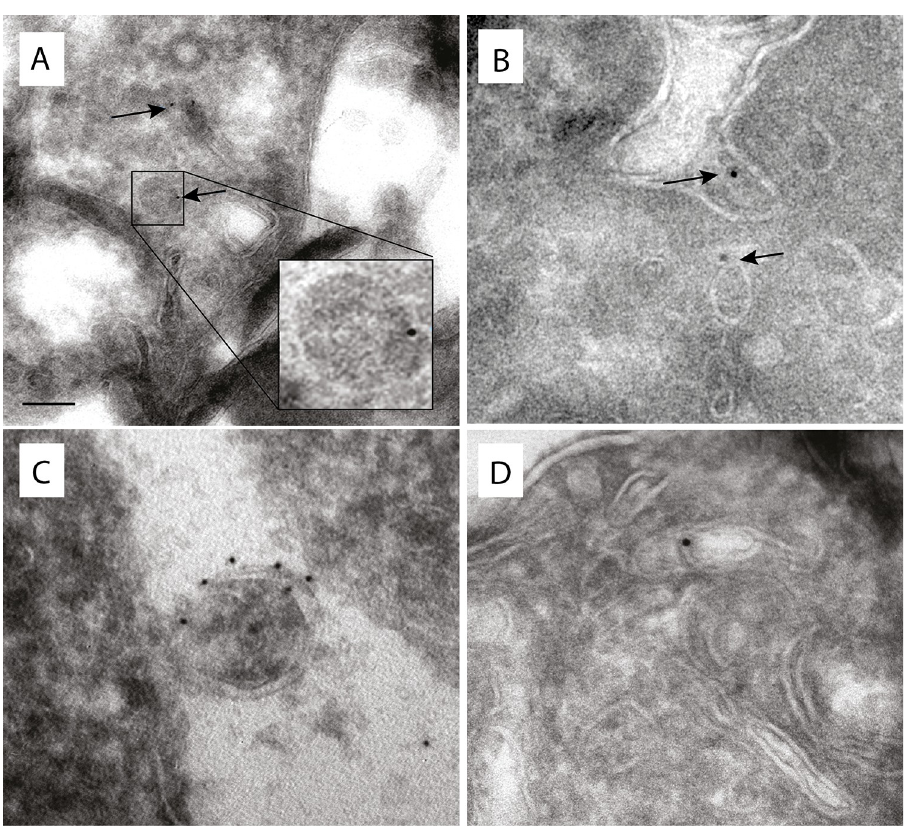
Fig 7. Immunoelectron microscopy detection of Pex14 and Pex16 in E . histolytica . Pex14 (A,B) was detected using Ni-NTA conjugated with 5 nm gold particles (A) or anti-V5 antibody (B). Pex16 (C,D) was detected using rabbit (C) and mouse (B) anti-His antibodies and the corresponding antibody conjugated with 5 nm gold particles. Scale bar: 100